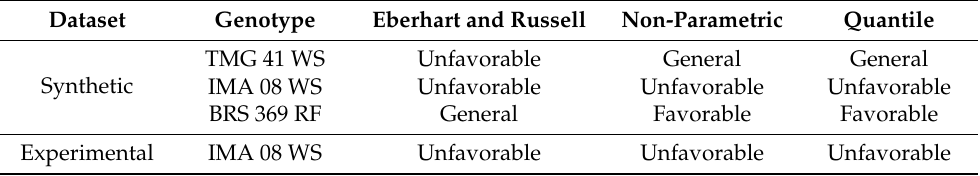
Table 5. Summary of changes in the classification in relation to the parameter of adaptability obtained using the Eberhart and Russell (1966), non-parametric and quantile Regression methodologies for three early cotton genotypes that deserves attention and should be analyzed carefully according to the measures used to assess influential points. Dataset Genotype Eberhart and Russell Non-Parametric Quantile TMG 41 WS Synthetic